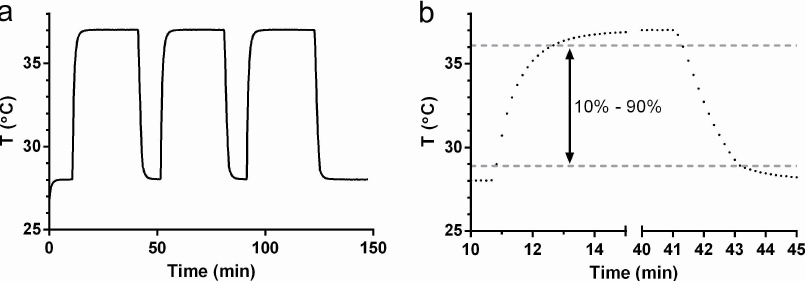
Fig 5. Adherence IVR temperature response analysis. (a) Temperature measuredby the thermistor as a function of time duringthree cycles of alternatingbetweentwo controlledtemperature chambers maintained at 28˚C and 37˚C, respectively.(b) Zoomed data for first cycle showingindividual temperaturereadings collectedat 10 s intervals. The lower and upper gray dotted lines indicatethe values at 10% and 90%, respectively, of the